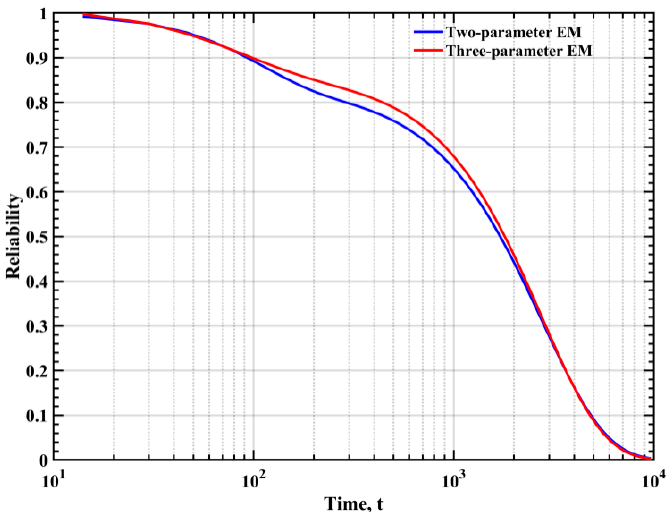
Figure 9. Fitted reliability functions of failure times.